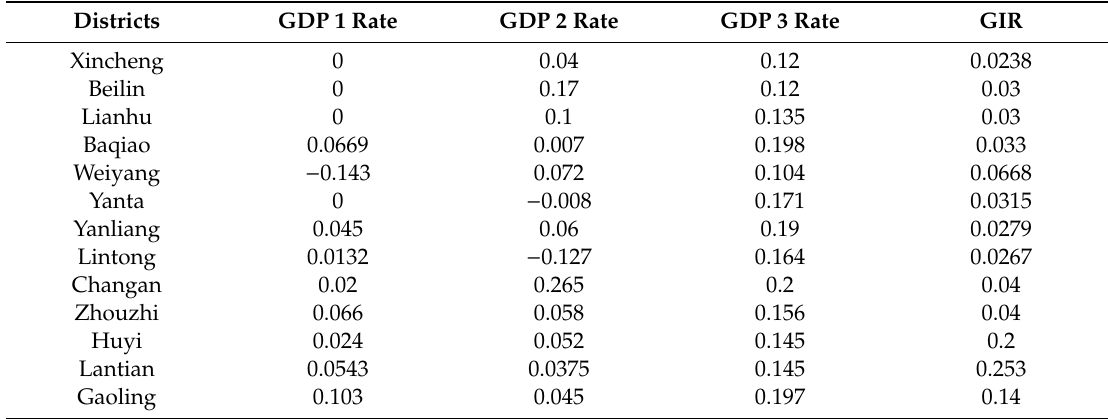
Table A2. Parameter setting of natural development scenario.